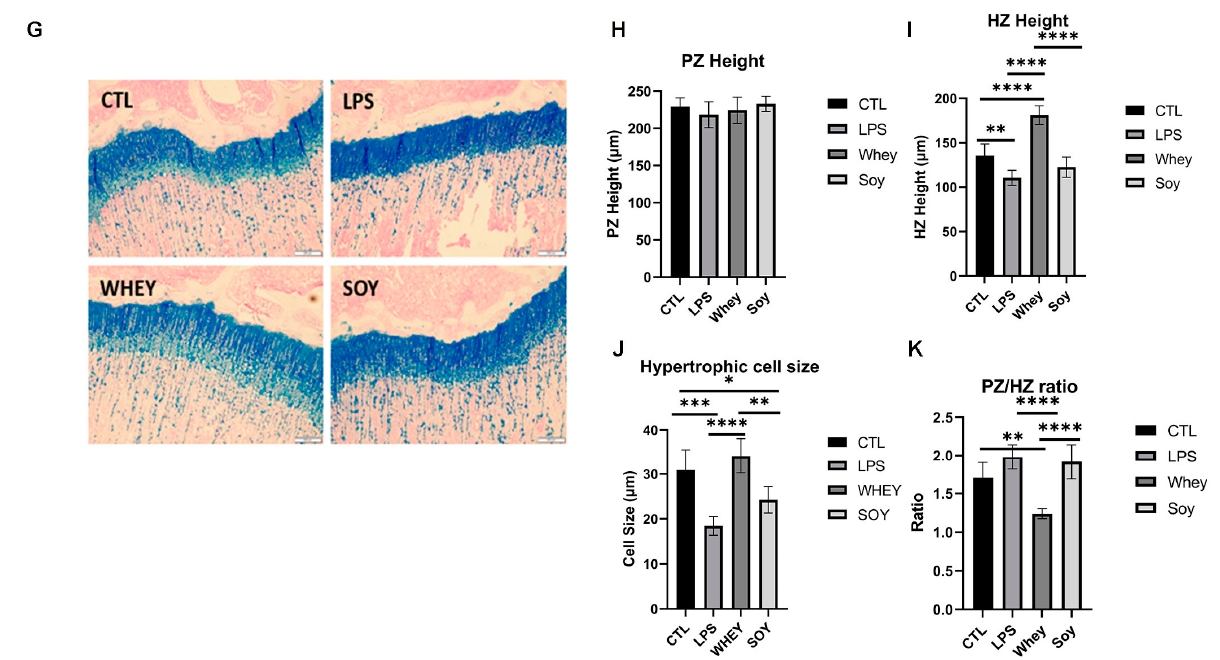
Figure 3. The effect of LPS and study diets on ( A ) weight, ( B ) food consumption, ( C ) spleen weight, ( D ) humerus length, ( E ) EGP height, ( F ) visual plot of EGP height, ( G ) representative stained sections of EGP from all groups, ( H ) PZ height, ( I ) HZ height, ( J ) hypertrophic cell size, ( K ) PZ/HZ ratio. ANOVA was used; ( A – E , H – K ) mean ± SD values are shown (n = 5/6 per group). * <0.05; ** <0.01; *** <0.001; **** <0.0001.